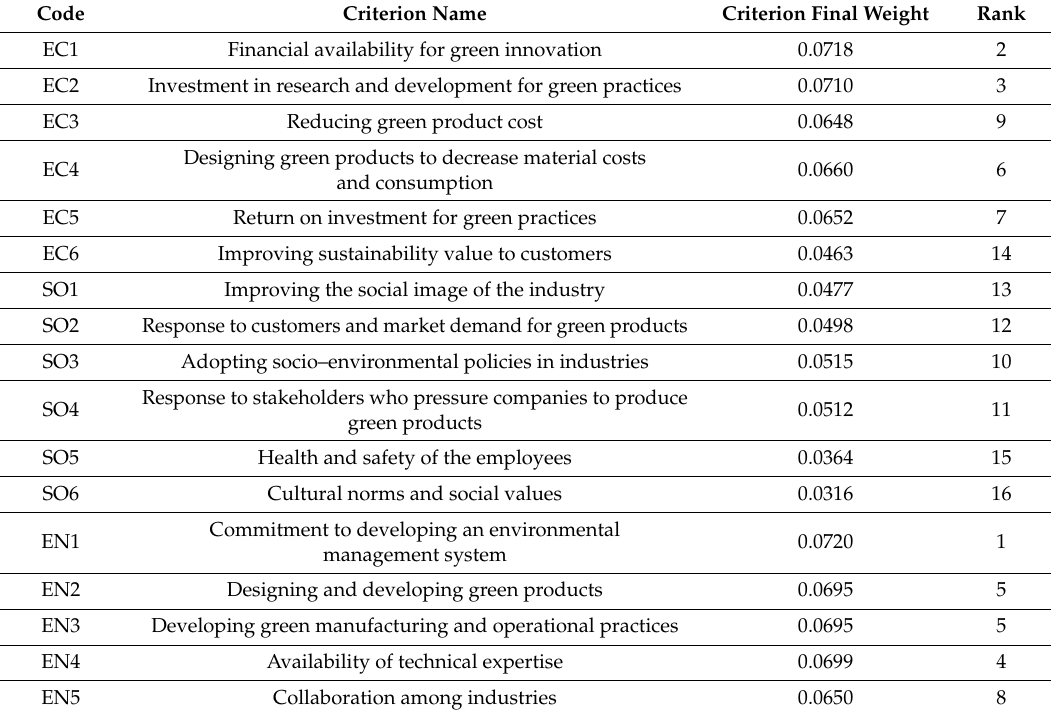
Table 7. Final weights of the overall